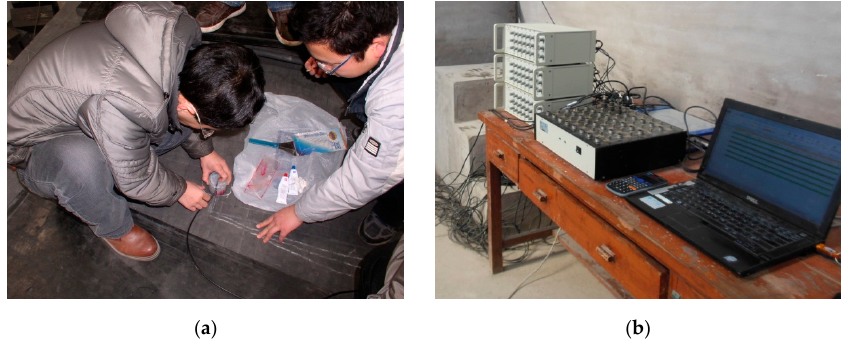
Figure 2. Sensor installation ( a ) and the signal collection system ( b ).